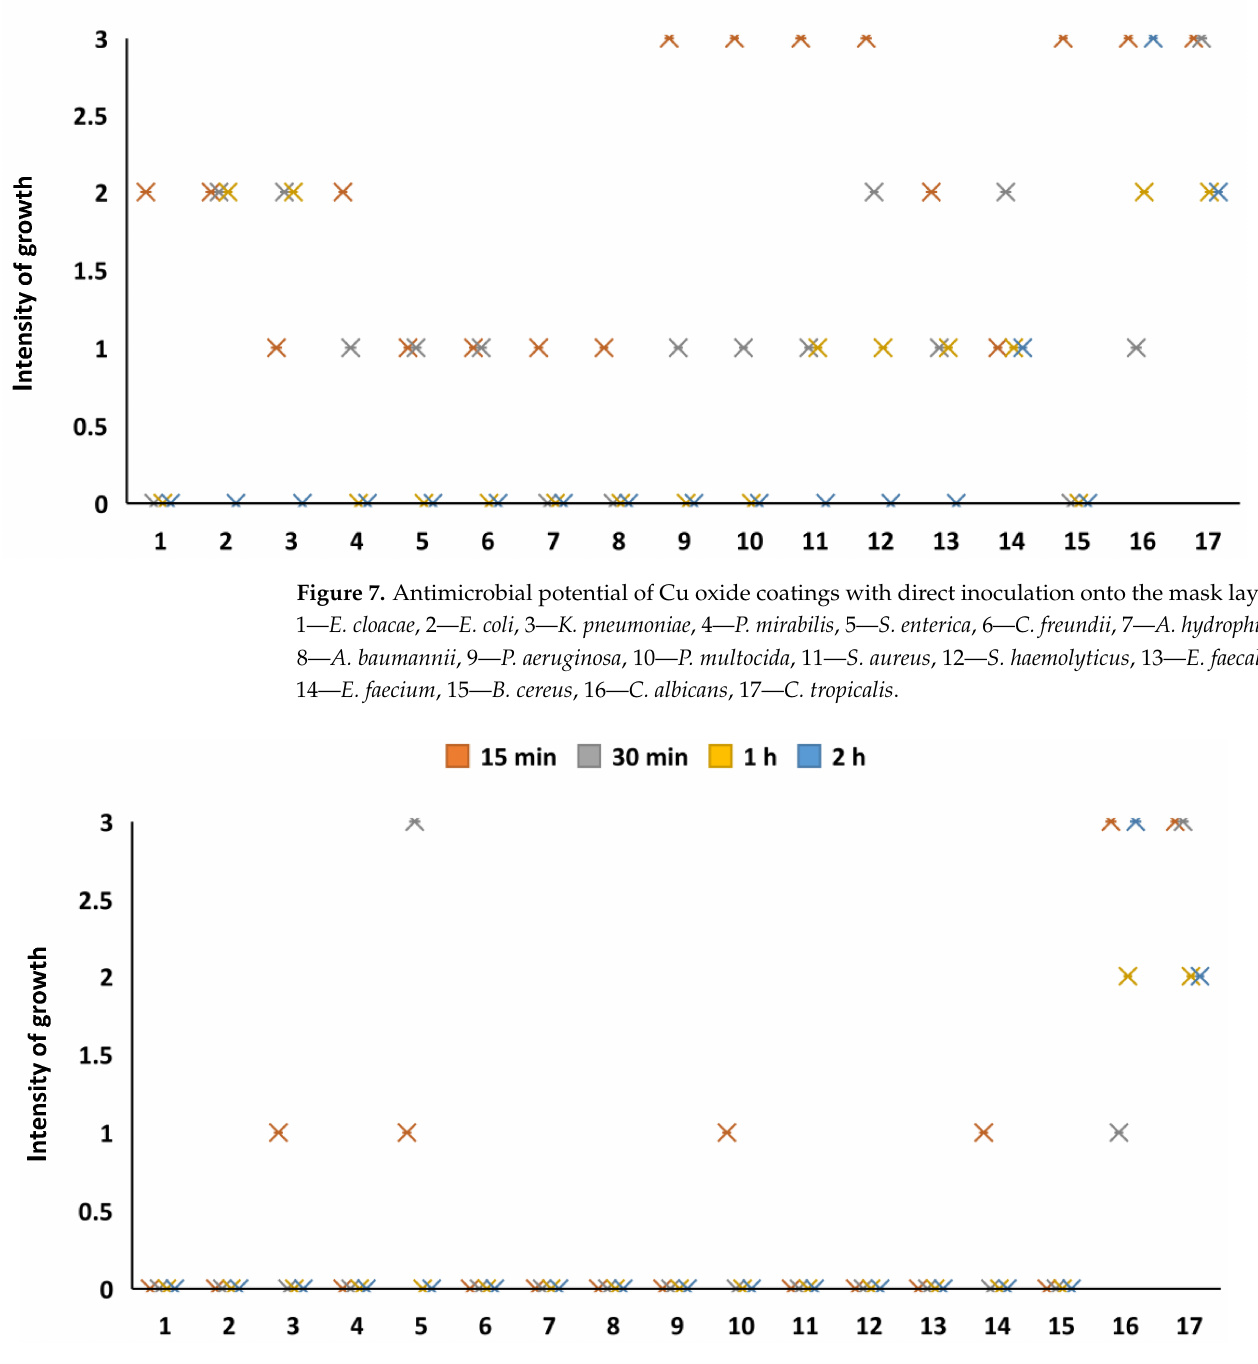
Figure 7. Antimicrobial potential of Cu oxide coatings with direct inoculation onto the mask layer.